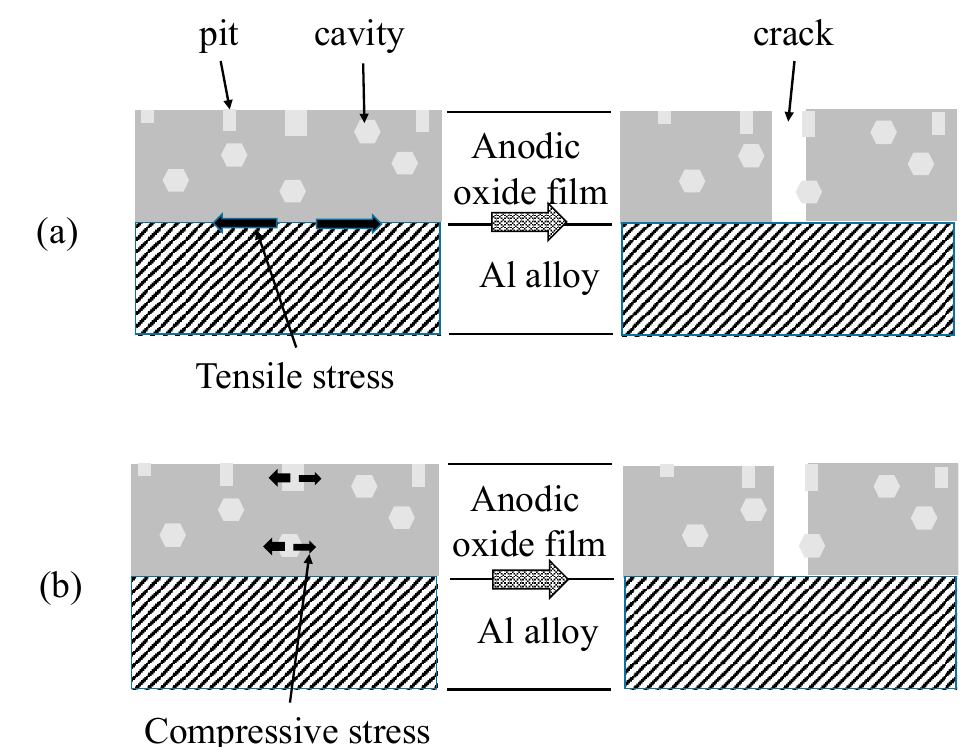
Figure 13. Schematic model of crack formation during pore filling.( a ) Tensile stress at the interphase between the anodic oxide film and the Al alloy substrate. ( b ) Compressive stress by the formation of hydroxides in pits and cavities.